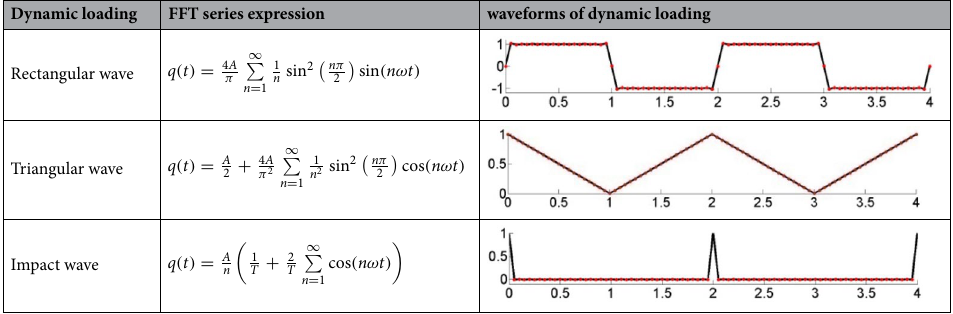
Table 3. The Fourier series expressions and waveforms of dynamic loading q ( t ) (A = 1).